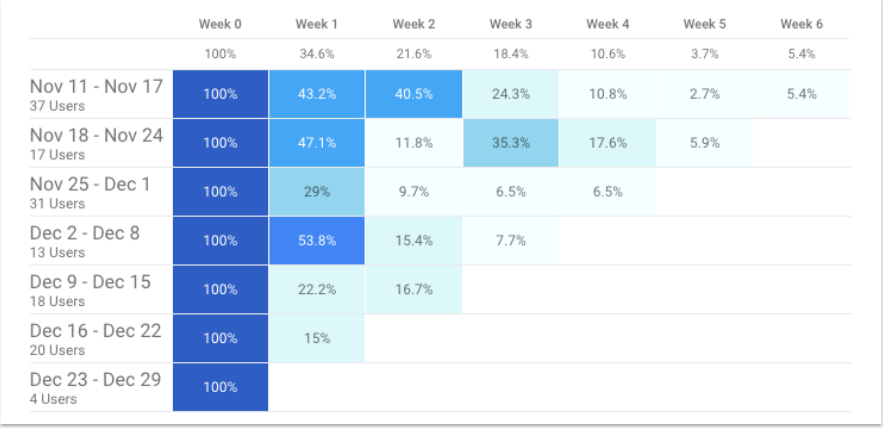
Figure 18. TeenPower mobile app—cohort report (from 11 November to 29 December)—the different shades of blue provide visual clues regarding the intensity or engagement of the users – a darker shade will imply a higher percentage. For instance, from all the users that started using the application in the week from November 18 to 24 (100%) only 35.3% used the application 4 weeks after (Week 3).